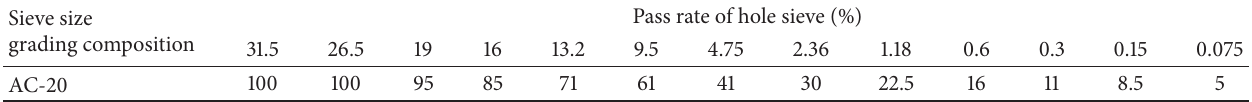
Table 2: Grading composition in AC-20 median asphalt concrete.